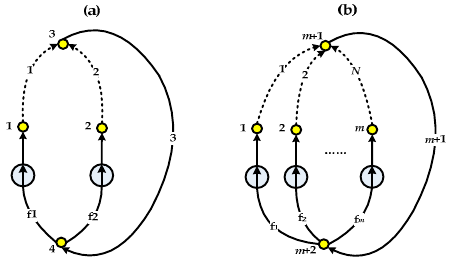
Figure 5. Secondary-side FFN of ( a ) 2 and ( b ) m modular high temperature gas-cooled reactor (MHTGR) plant by independent feedwater strategy.